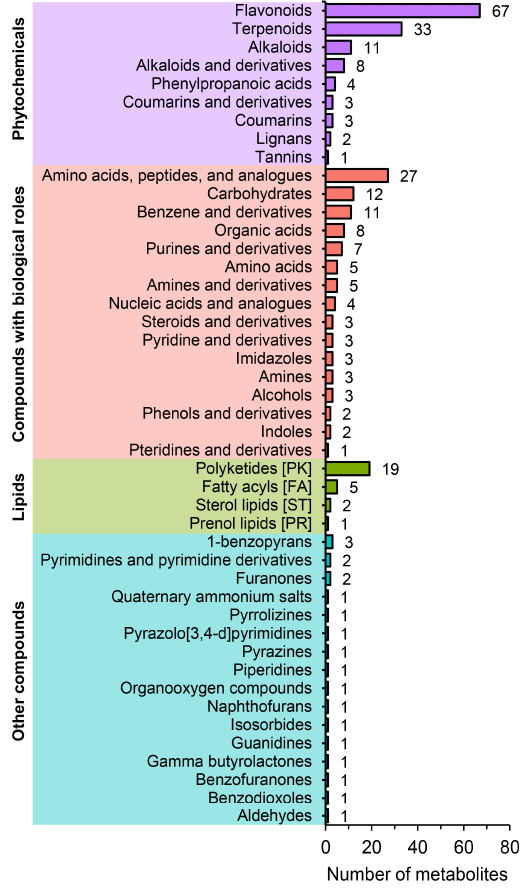
Figure 2. Identification and classification of the metabolites from CX and LX.